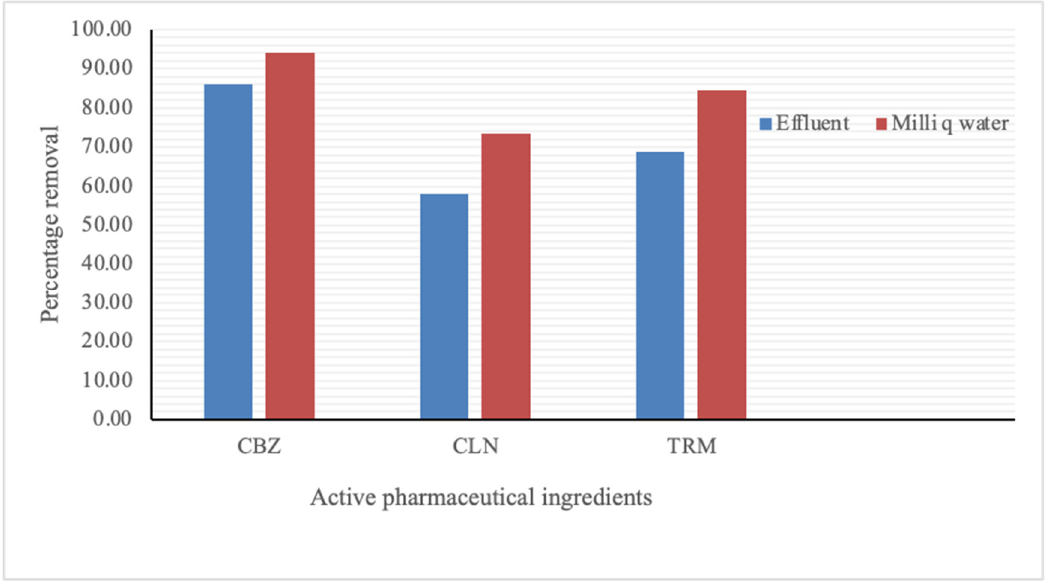
Figure 2. Percentage sequestration of APIs from affluent and Milli-Q water at equilibrium.